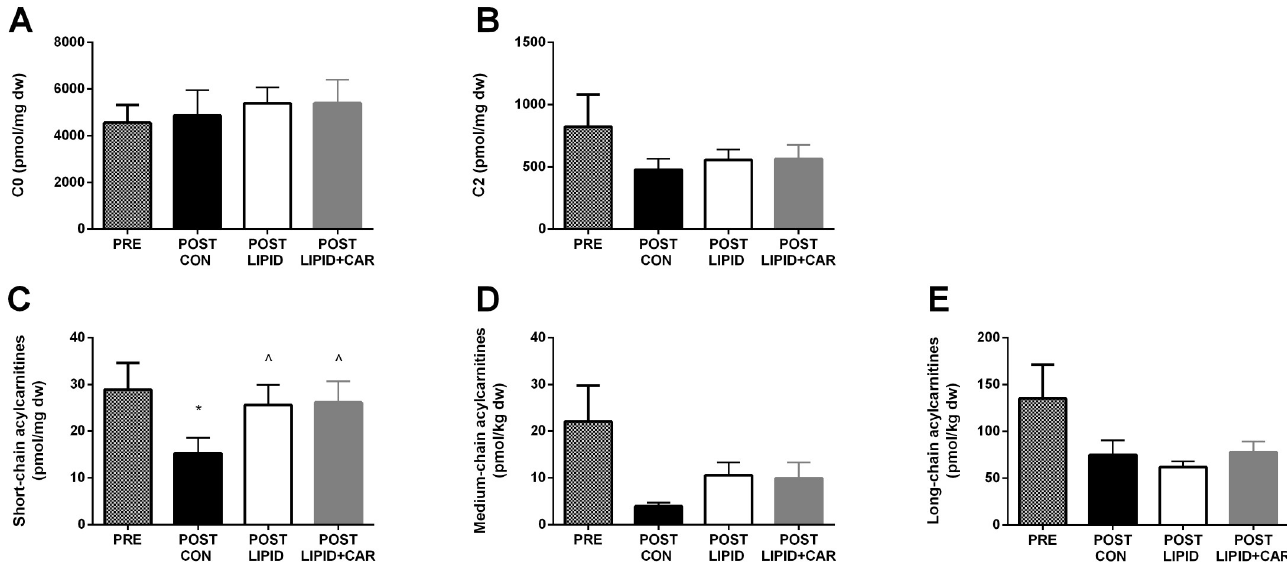
Fig 5. Skeletal muscle acylcarnitine profiles. Skeletal muscle acylcarnitine concentrations measured in biopsies at the end of the 6-hour hyperinsulinemic- euglycemic clamp (n = 8). Black bars represent the control group, white bars the LIPID group and light grey bars the LIPID+CAR group. Dark grey bars represent the pre-clamp muscle biopsy. Data are expressed as means ± SEM. � significantly different from PRE ( P < 0.0125 after Bonferroni correction for multiple testing), ^ tending to be different from CON ( P < 0.10).